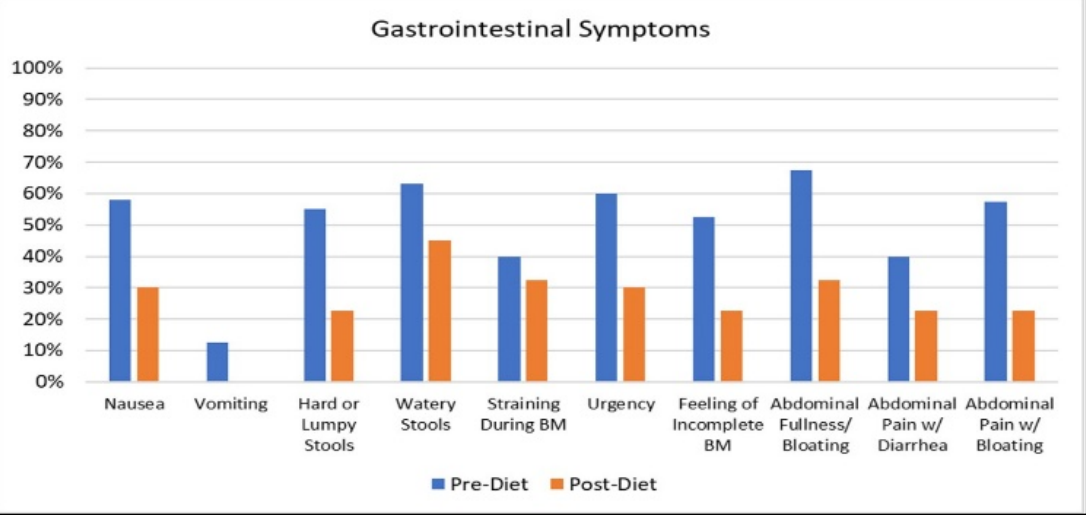
Figure 3. The percentage of veterans reporting neurological and other symptoms pre–post diet. Reductions in the severity of symptoms were also noted after one month on the diet. Subjects did report a reduction in the severity of joint pain even though most did not have this symptom remit completely. Symptom severity changes are illustrated in Figure 4. Since these are not normally distributed, median scores are presented at baseline and post-diet.